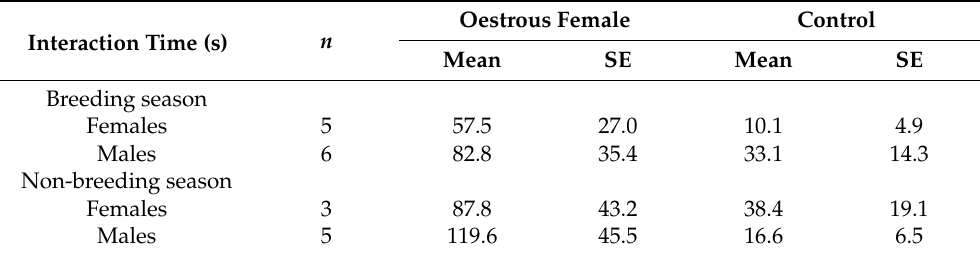
Table 1. Mean ( ± SE) time spent by stoats interacting with the bedding odour of an oestrous female stoat during the breeding and non-breeding seasons. The odours were collected on Dacron bedding material and compared with a blank piece of Dacron